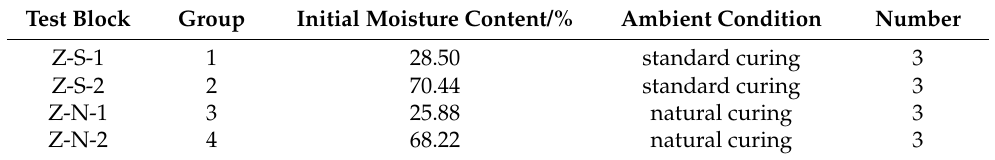
Table 8. Test program of drying shrinkage performance.